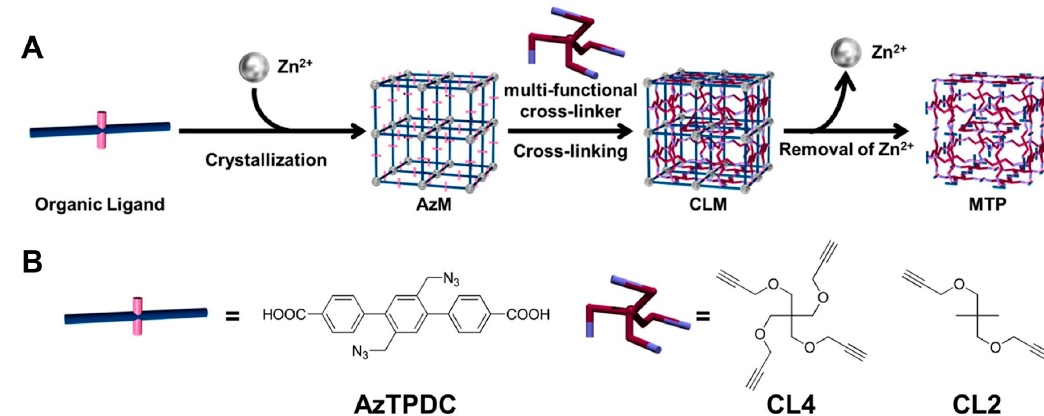
Figure 9. ( A ) Schematic illustration of cross-linking of the organic linkers in MOF (AzM) and subsequent decomposition to obtain polymer gel (PG). ( B ) Molecular structures of the organic ligand (AzTPDC) and the cross-linkers. Reproduced with permission from Ref. [145] Copyright 2013, American Chemical Society.